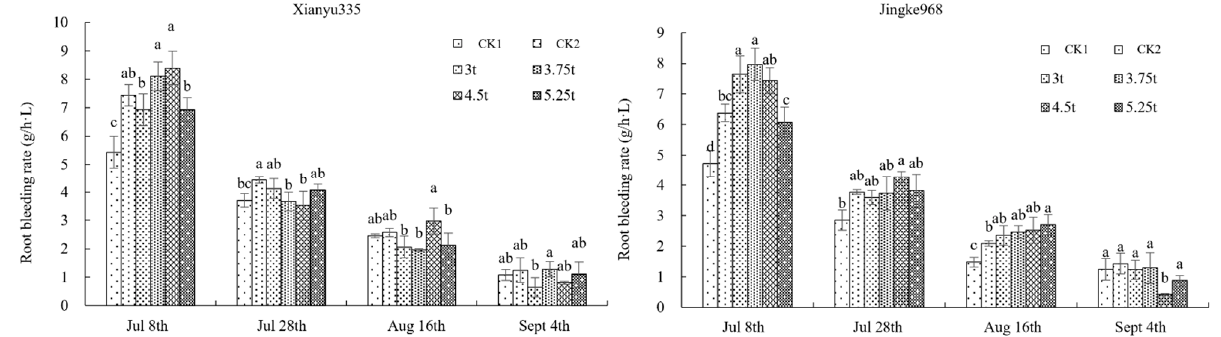
Figure 4. Effects of the carbon-based fertilizer on the maize root bleeding rate. Notes: data are expressed as mean ± standard deviation. Different letters within the same column indicate a significant difference at the 5% level.